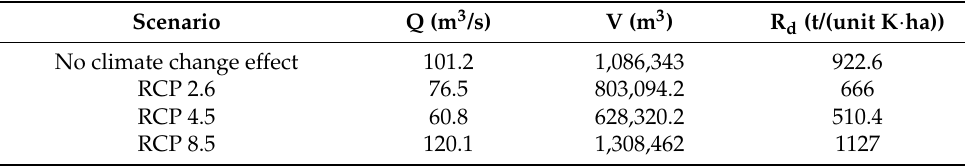
Table 5. Peak flow rate (Q) and volume (V) and event runoff factor (R d ) for the various scenarios, considering the flood event generated by 4 September 2011 rainfall event and using AMC III to produce surface runoff at Sarnico station. Scenario